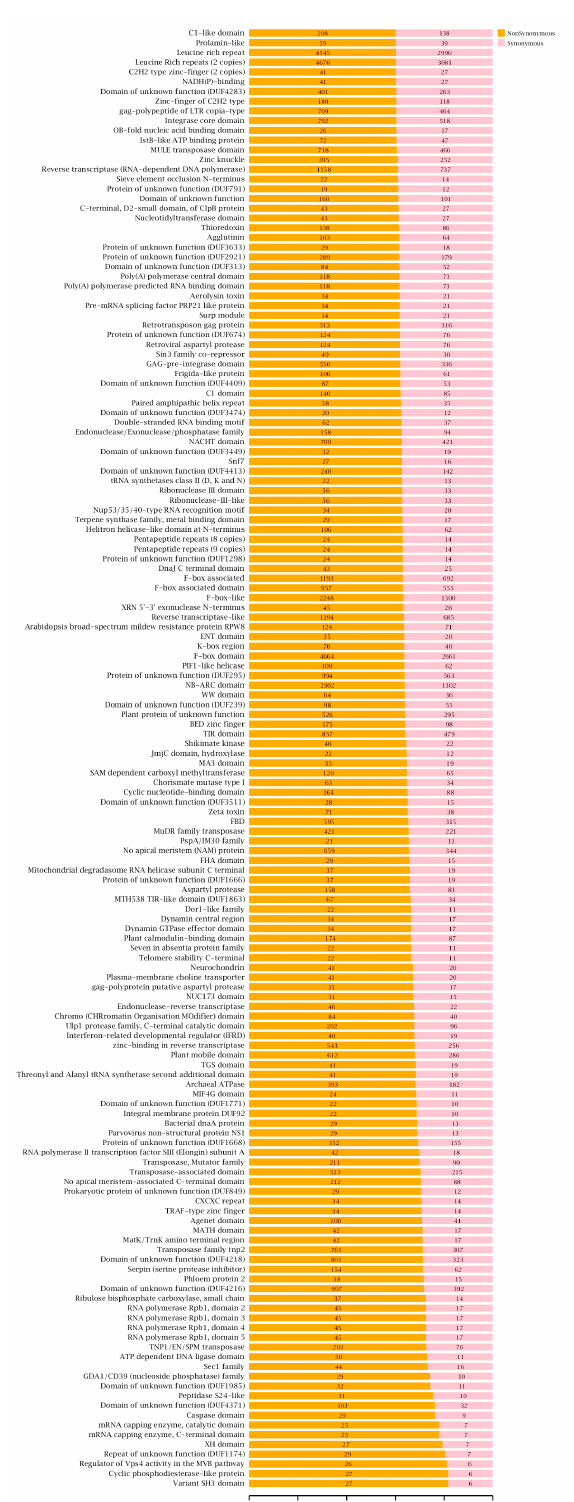
Figure 6. The distribution information of nonsynonymous (nonsyn) and synonymous (syn) SNPs in different Pfam-containing genes in Fragaria genomes. The Pfam-containing gene families with more than 30 nonsyn and syn SNPs (ratio of nonsyn to syn SNPs > 0.6) were analyzed and listed. The chi 2 significance of the involved nonsyn and syn SNP distributions in each Pfam group was evaluated, p -value <